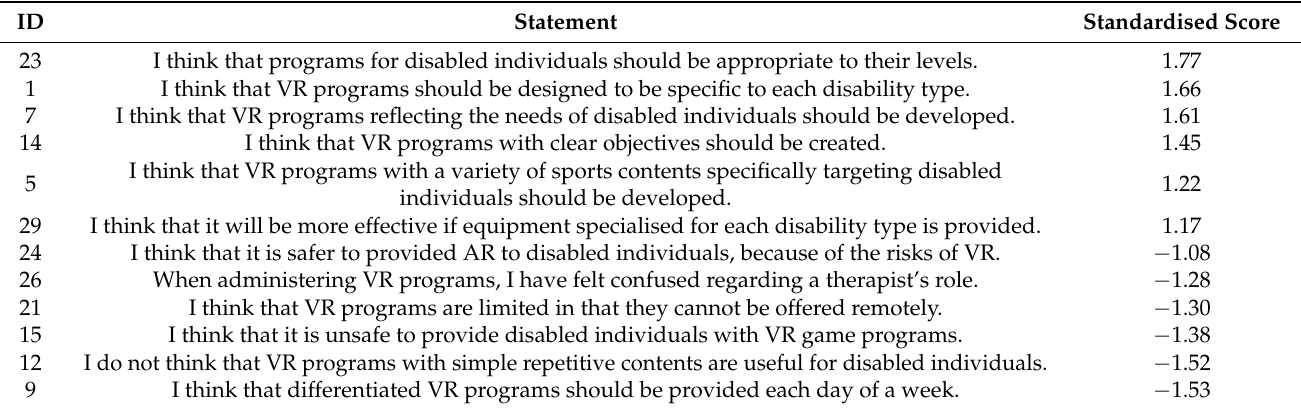
Table 6. Type 1 statements and standardised scores ( ± 1.00 and above).